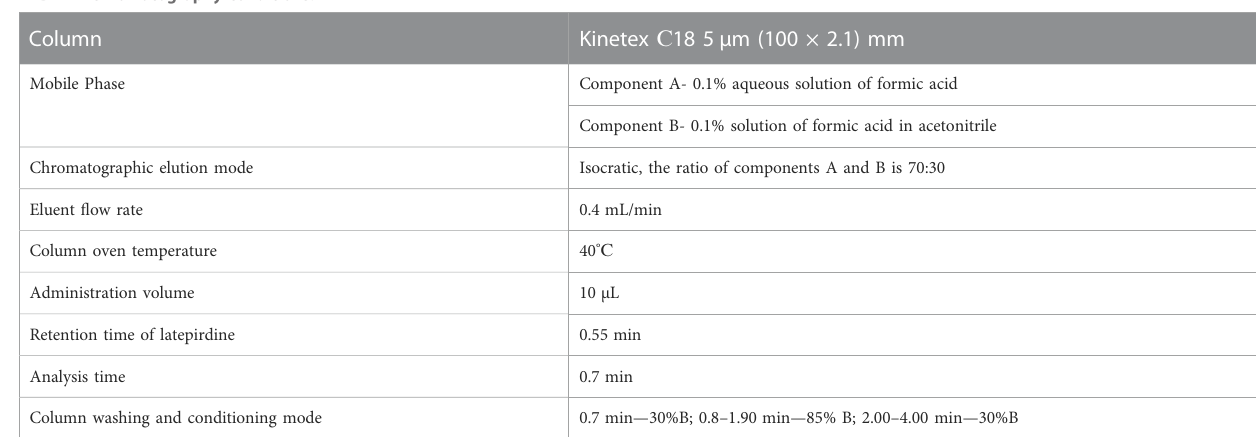
TABLE 2 Chromatography